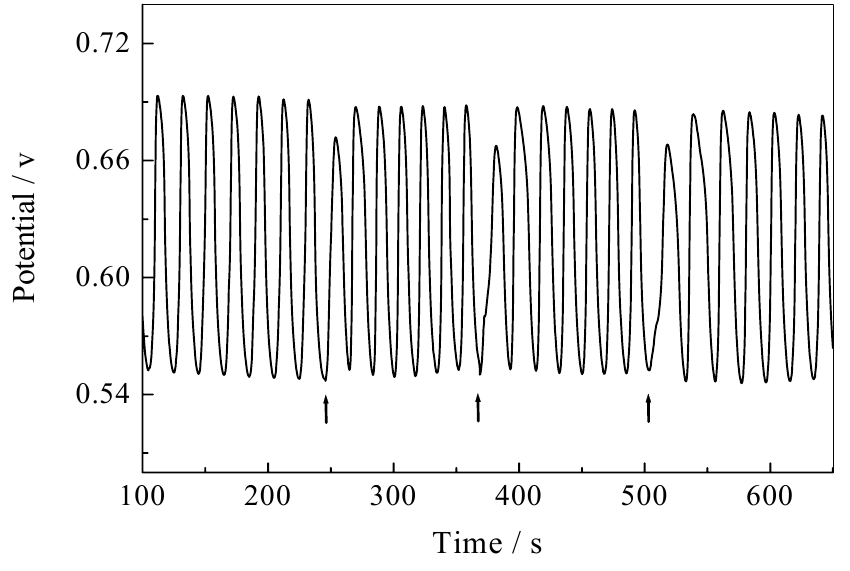
Fig. 2 Typical oscillation profile obtained in the absence and presence of SNA perturba- tion. Arrows indicate the addition of